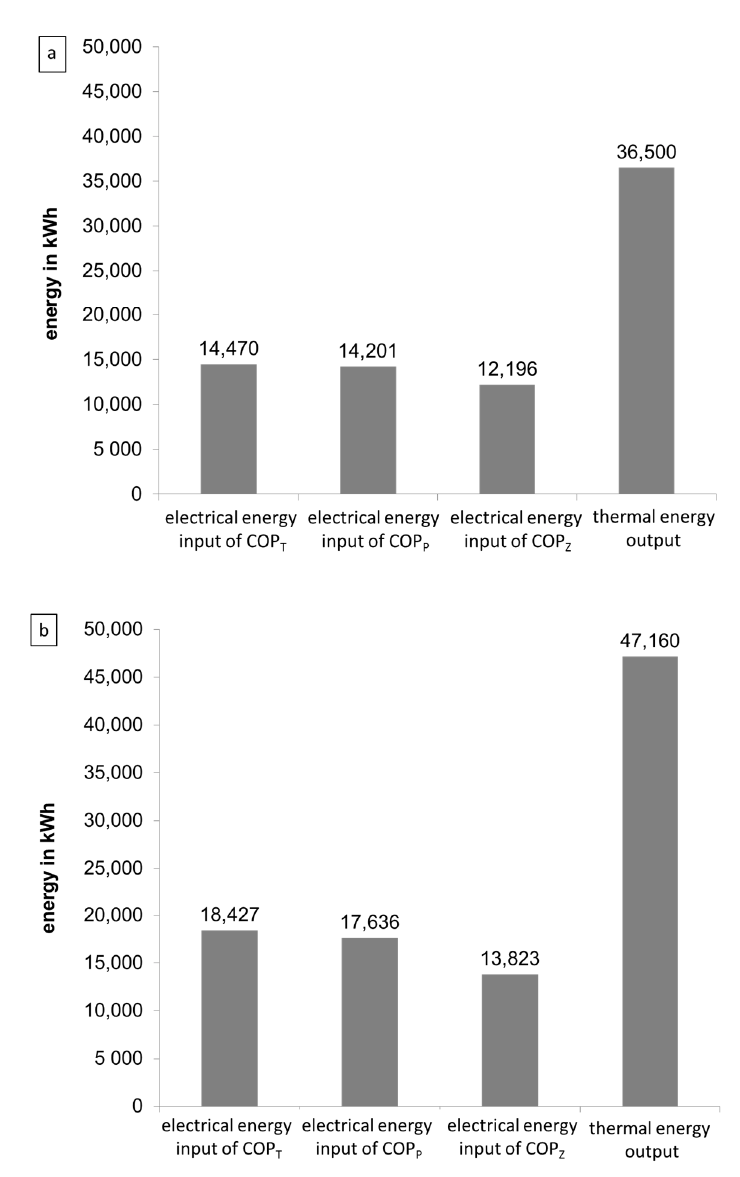
Figure 6. Electrical energy input depended on the different assessment limits (see Section 2.3) and thermal energy output during the experimental period in ( a ) the farrowing barn and in ( b ) the piglet-rearing barn.